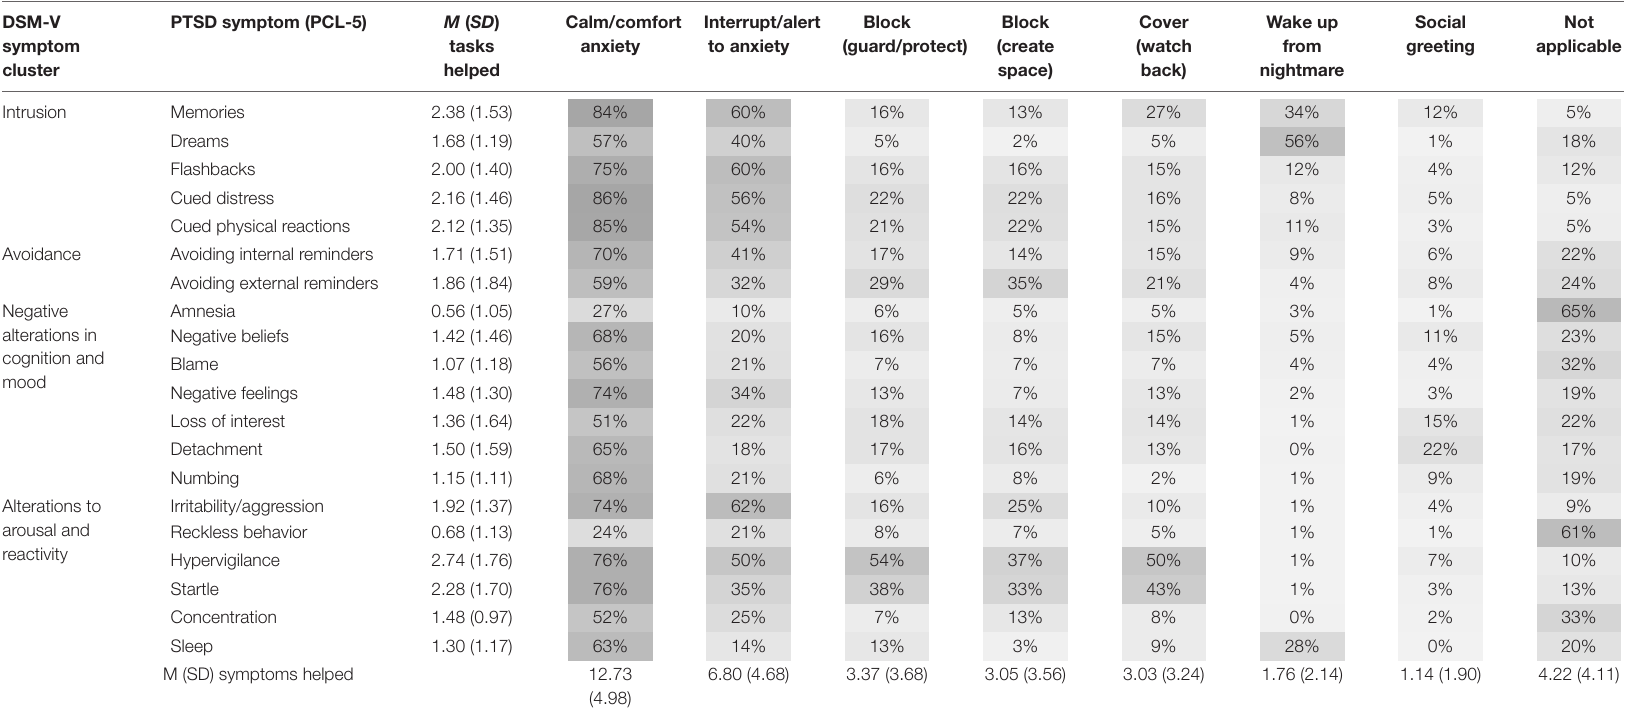
TABLE 4 | Means, standard deviations, and population percentages of the PTSD symptom specificity of trained behaviors. DSM-V